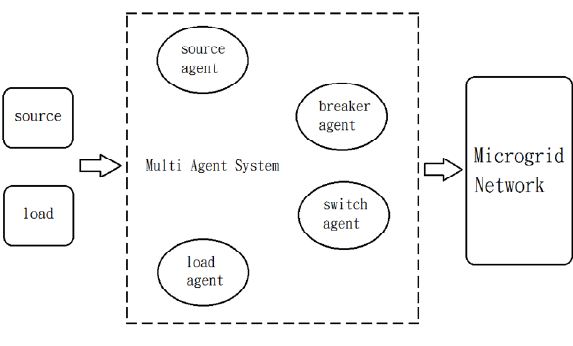
Figure 6. Relationship chart between micro grid and each